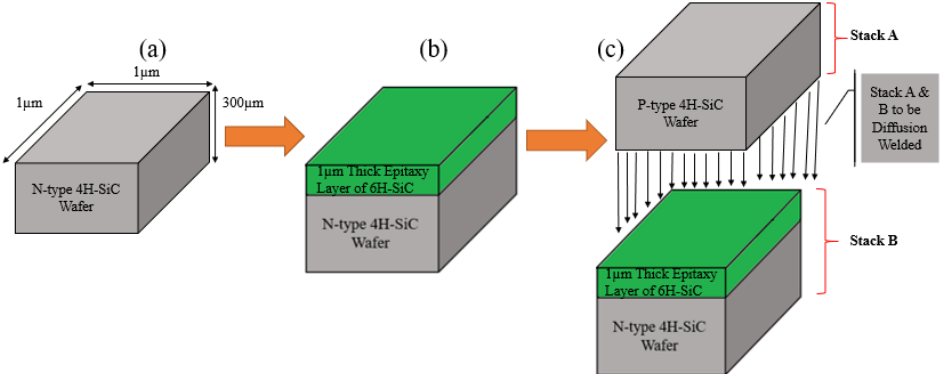
Figure 2. Simulation steps of proposed SiC-based light-emitting diode ( a ) 300 µm thick wafer of N-type 4H-SiC; ( b ) deposition of an epitaxial layer of intrinsic 6H-SiC on 300 µm thick wafer of N-type 4H-SiC; ( c ) diffusion welding of 300 µm thick p-type 4H-SiC (Stack A) wafer with Stack B (n-type 4H-SiC and 6H-SiC).